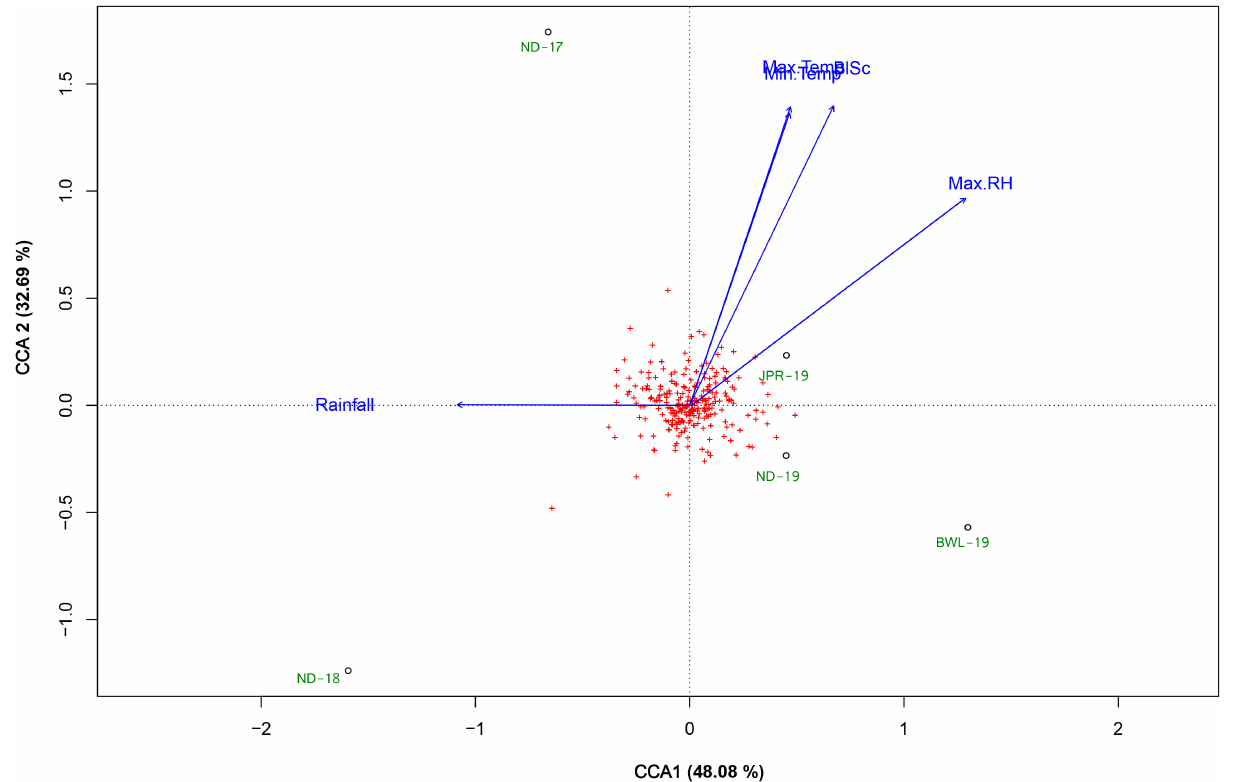
Frontiers in Plant Science |